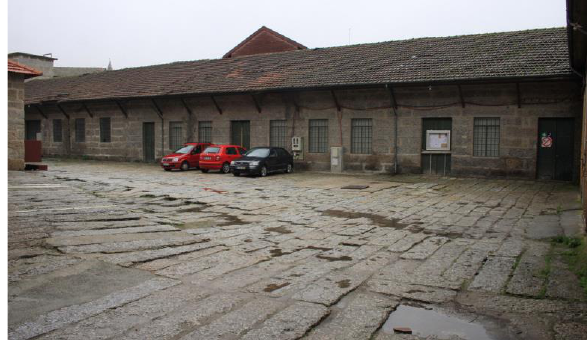
Figure 7. Former Factory António José de Oliveira e Filhos Source: Archive of Guimarâes turismo.